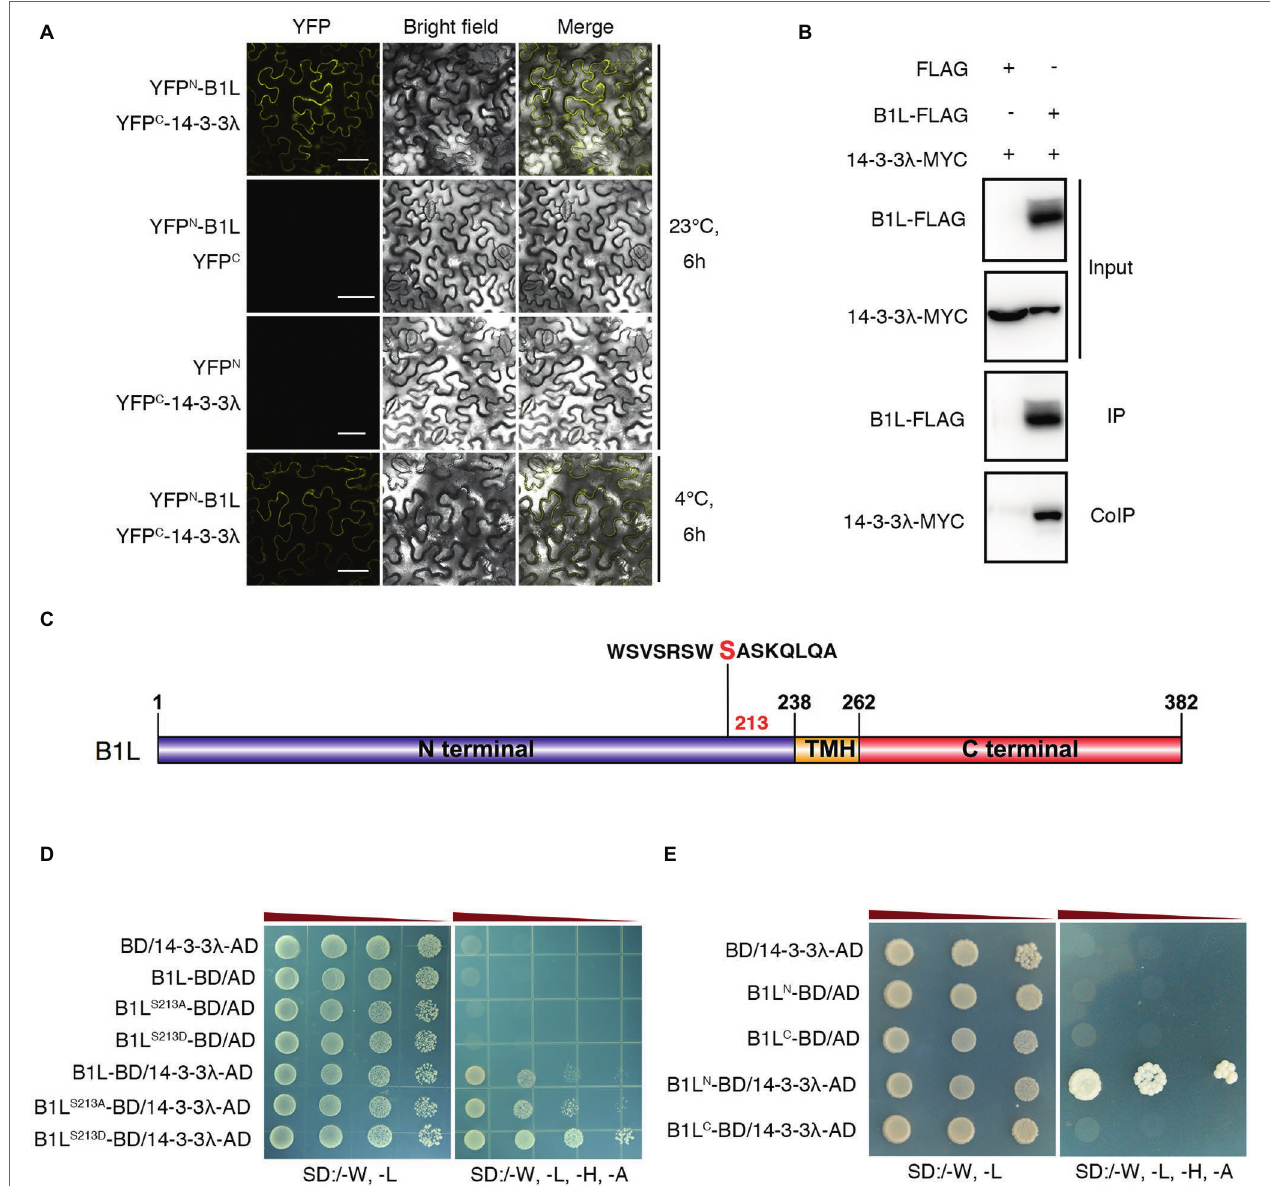
FIGURE 4 | B1L interacts with 14-3-3 λ , and serine 214 in the N-terminal of B1L modulates the interaction between B1L and 14-3-3 λ . (A) BiFC analysis in N. benthamiana showing the interaction between B1L and 14-3-3 λ . The plants were pretreated with or without 4°C for 6 h, and then, the YFP signals were detected. Bar = 50 μm. (B) CoIP assay showing the interaction between B1L and 14-3-3 λ in plants. Total proteins were extracted from transformed N. benthamiana leaves, immunoprecipitated with an anti-FLAG antibody, and detected with an anti-MYC antibody and an anti-FLAG antibody. (C) Diagram of B1L- truncated proteins and B1L-mutated proteins used for the Y2H assays. Serine 213 in the N-terminal of B1L was a candidate phosphorylated site that can be recognized by 14-3-3 proteins. This site was mutated to alanine (B1L S213A ) and aspartic acid (B1L S213D ) to mimic nonphosphorylation and autophosphorylation of B1L, respectively. The N-terminal (amino acids 1-238) and the C-terminal (amino acids 262-382) of B1L were used to identify the binding domain of B1L that interacts with 14-3-3 λ . (D,E) Y2H analysis of the interaction between 14-3-3 λ and B1L native protein, B1L-mutated proteins or B1L-truncated proteins. Panels show yeast serial decimal